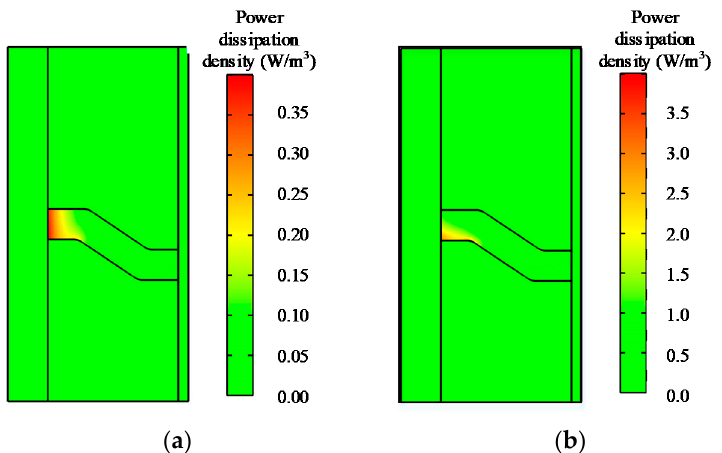
Figure 8. Power dissipation density in the cone spacer with pure epoxy or aged SiC/epoxy mi-cro- composites: ( a ) pure epoxy; ( b ) 1080 h-aged SiC/epoxy micro-composites.